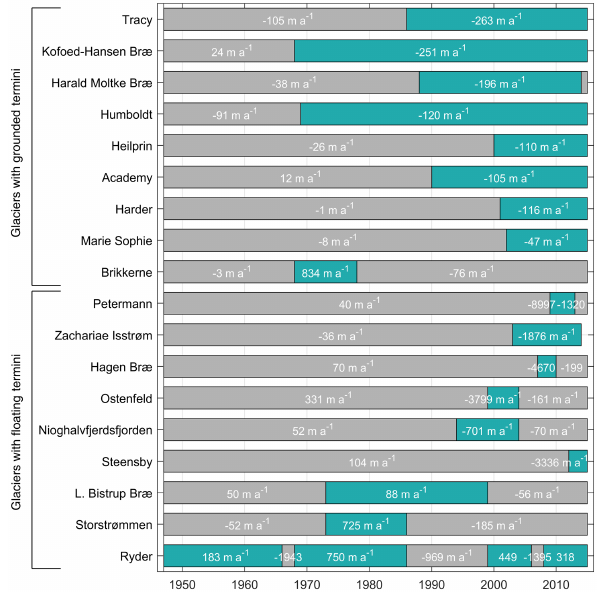
Figure 5. Retreat rates during identified change point time periods for each pre-defined category of glacier based on either grounded or floating termini. Glaciers are then ordered based on their overall (1948–2015; Table 1) frontal position change rates within each of these categories. Grey bars show their periods of minimal/variable terminus change (in some cases advance), and turquoise bars show the period of higher-magnitude frontal position